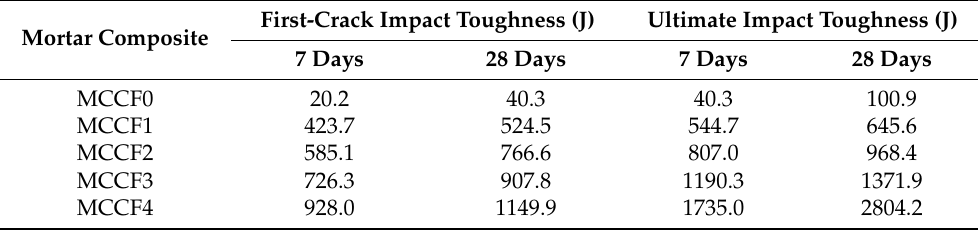
Table 5. Impact toughness of various mortar